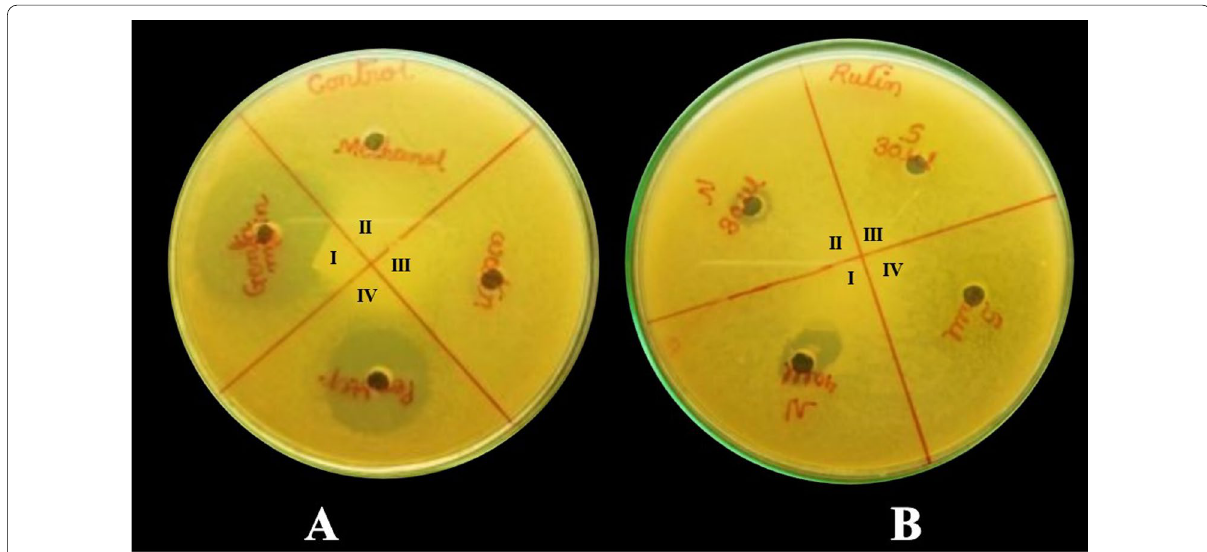
Fig. 14 Antibacterial activity against S. aureus : Control: AI . Gentamicin, AII . Methanol, AIII . DW, AIV . PenStrep BI . AgNPs (40 µl), BII . AgNPs (30 µl), BIII . Rutin (30 µl), BIV . Rutin (40 µl)